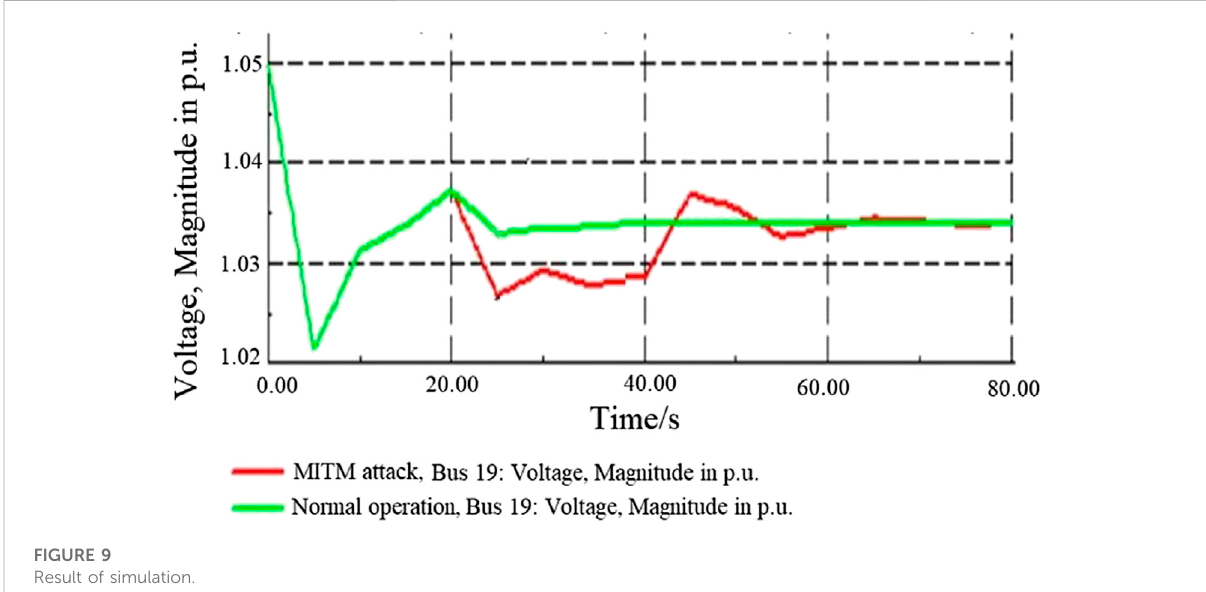
FIGURE 9 Result of